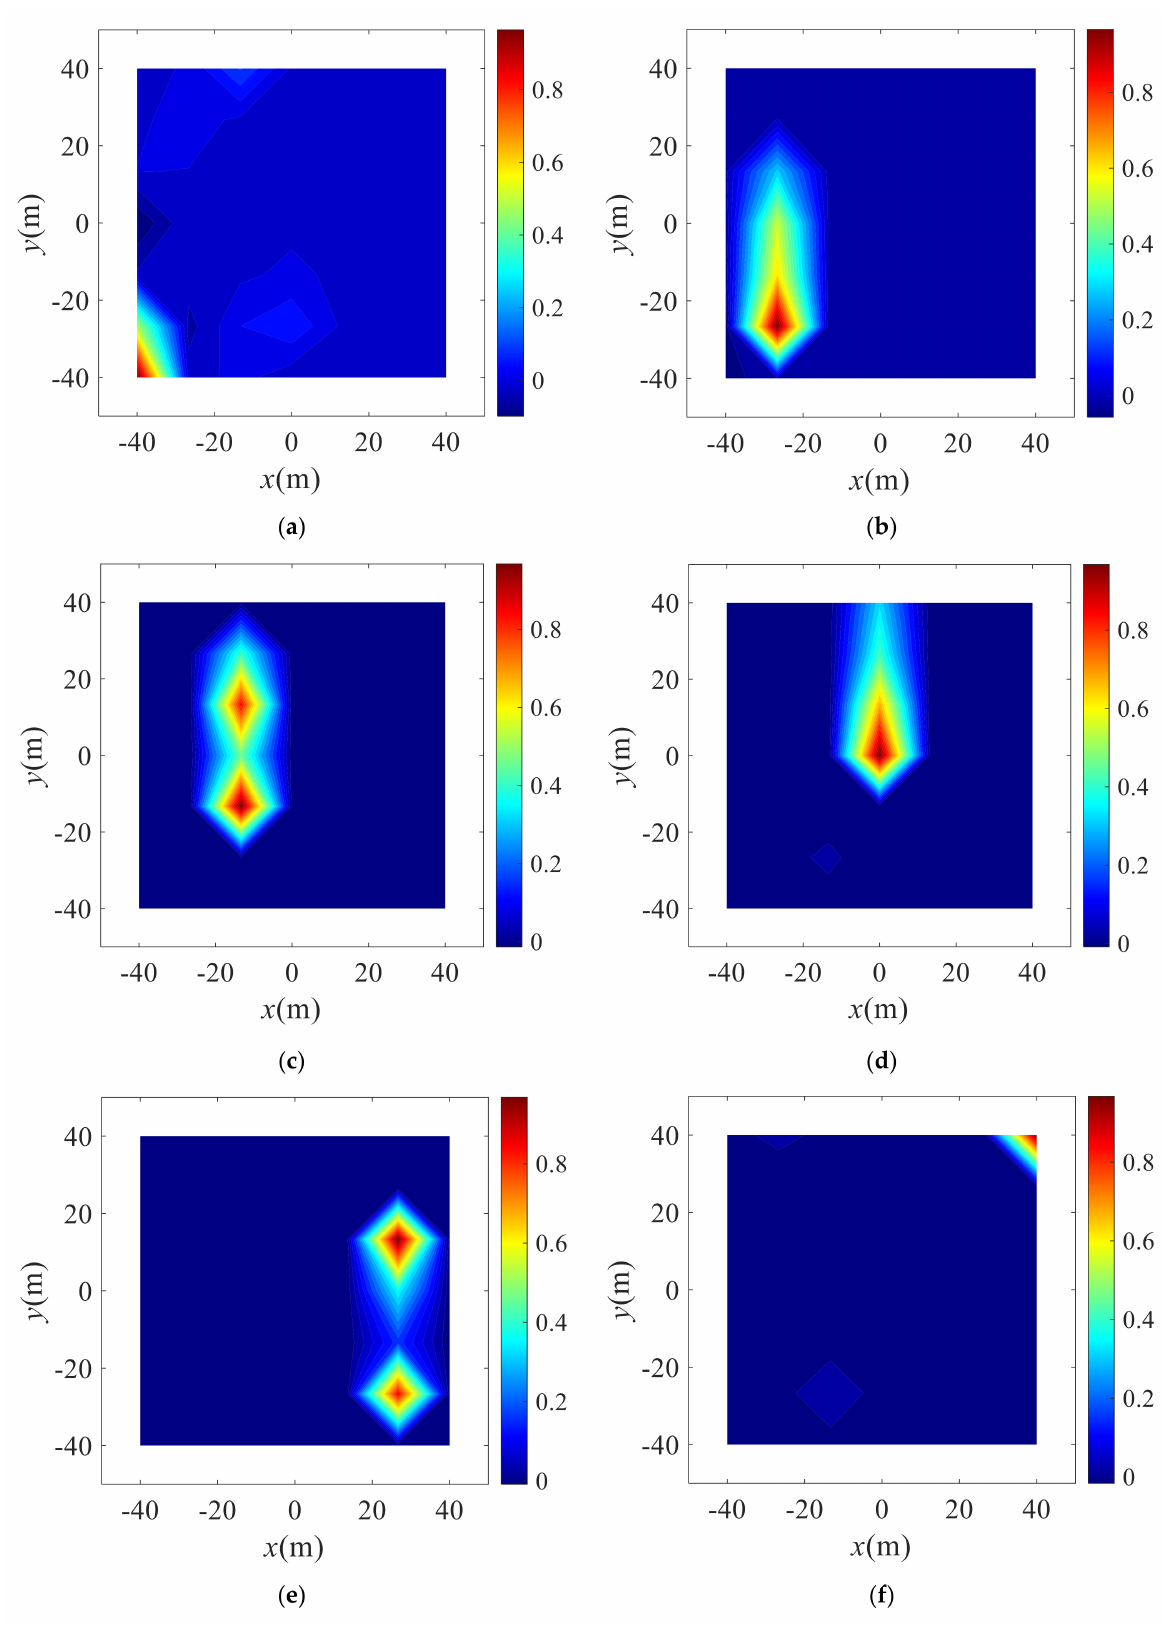
Figure 7. Correlation coefficients of the sensor #i vs. all: #37 ( a ), #28 ( b ), #29 ( c ), #20 ( d ), #22 ( e ) and #49 ( f ) (Rif. Figure